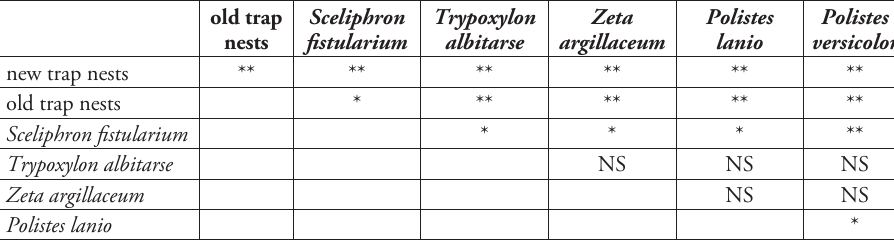
Table 2. Differences in nesting success of Trypoxylon nitidum among different substrates, based on Ta- ble1. Results of Fisher’s exact test of successes and failures among pairs of substrates, based on Table 1.